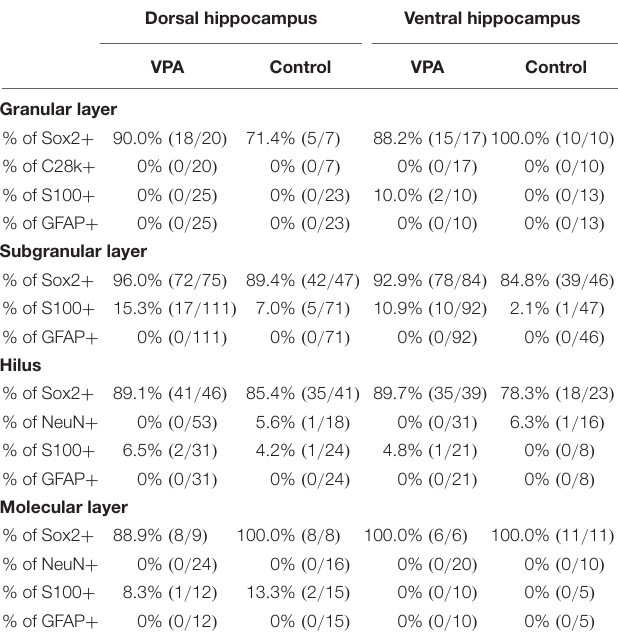
TABLE 2 | Percentages of cells immunostained for various markers in BrdU-labeled cells in dentate gyrus of hippocampus in VPA-treated ferrets on PD